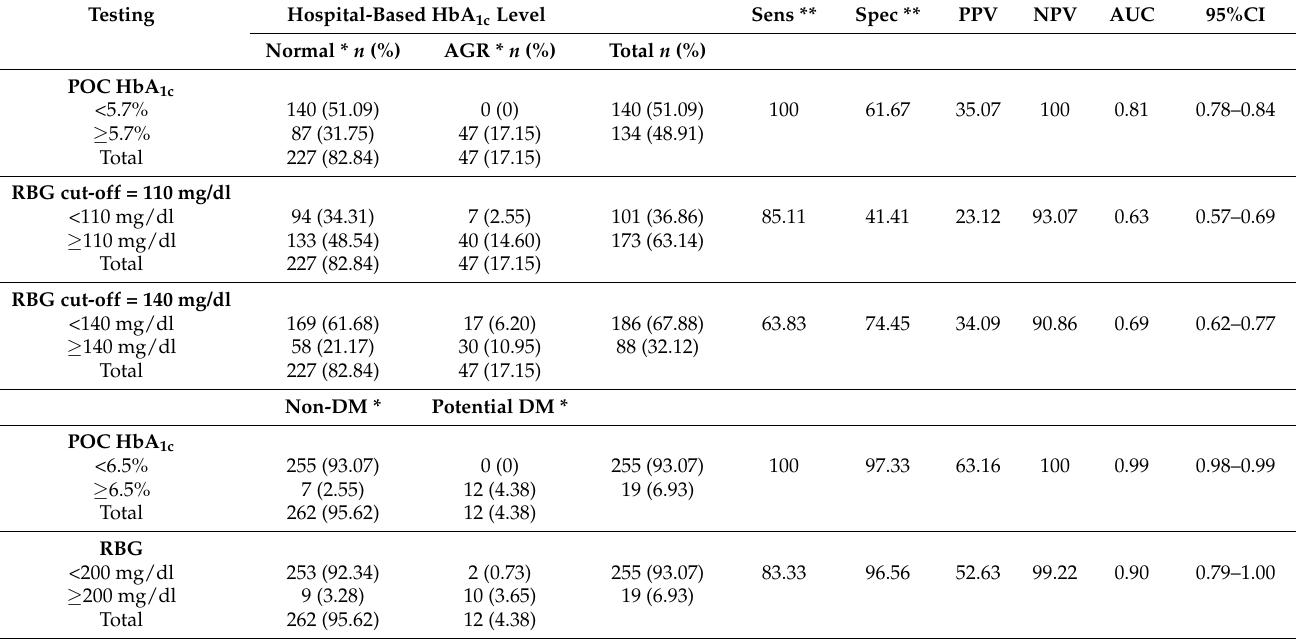
Table 4. Sensitivity, specificity, PPV, and NPV of POC testing compared to hospital-based laboratory testing using HbA 1c levels. ( n = 274).